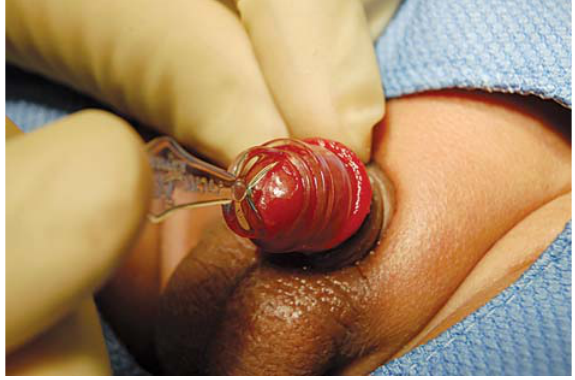
Figure 1 – Calibration of glans with Plastibell™. Figure 2 – Approximating internal and external layers at the apex of dorsal slit.